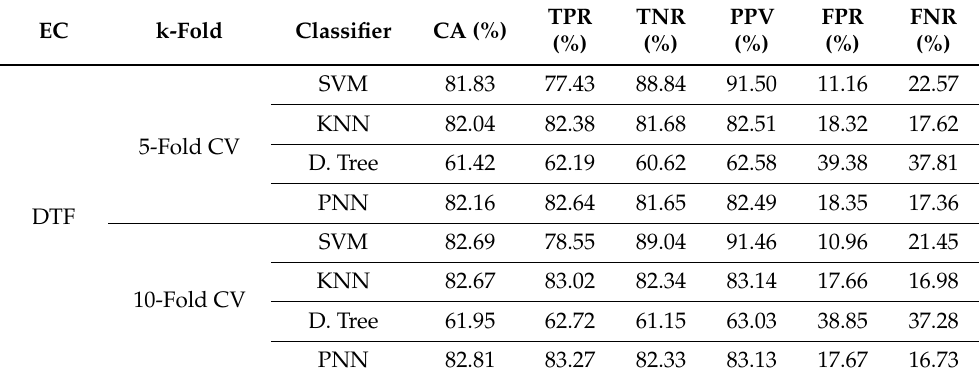
Table 3. Performance in left/right MI EEG classification when using the DTF. EC